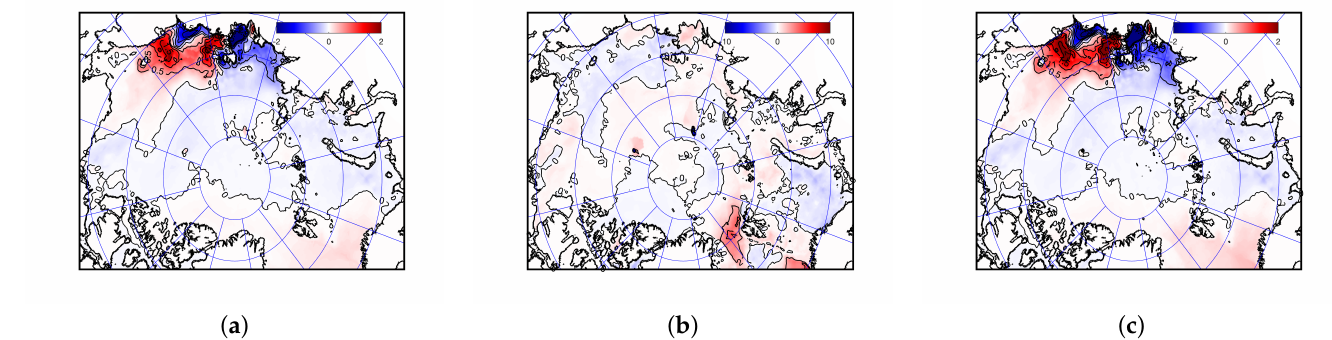
Figure 16. Annually averaged deviations in ( a ) mass of water (kg/m 2 ), ( b ) its heat content (MJ/m 2 ), and ( c ) mass of salt (kg/m 2 ) per square meter of the Arctic area (above 65 N), obtained as a result of vertical integration from the surface to the ocean floor in terms of incremental values in numerical experiment C1 to experiment